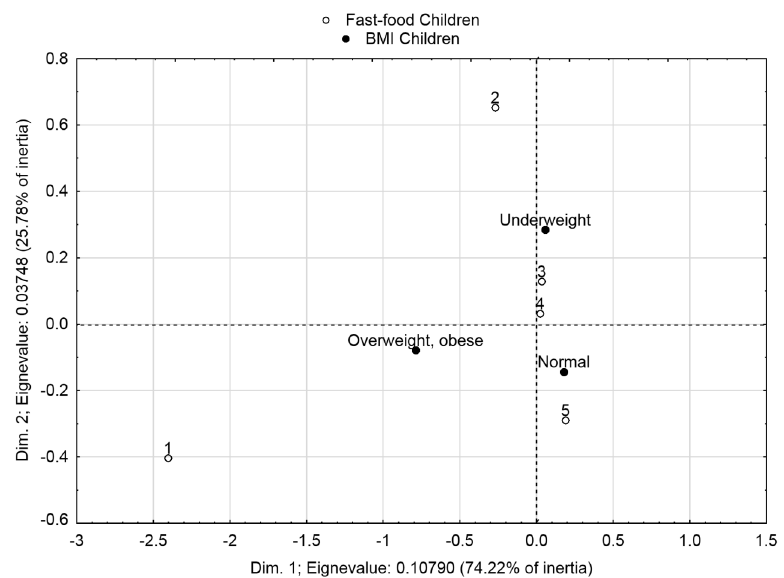
Figure 3. Correspondence map of the frequency of fast-food consumption and the “child BMI” category. Frequency of consumption: 1 – daily, 2 – several times a week, 3 – once a week, 4 – sporadically, 5 – never existence of normal weight (n = 37) and age category “5” (the upper-right section of the map); overweight and obesity (n = 10) with age category “3” (the upper-right section of the map); and underweight (n = 25) and age category “4” (the lower-left section of the map) can be observed. There exists a statistically significant relationship between the age groups and child BMI (chi-squared test, p =